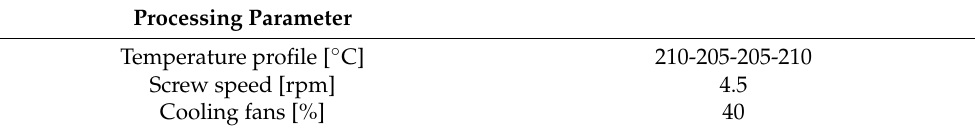
Table 4. Filament fabrication parameters.